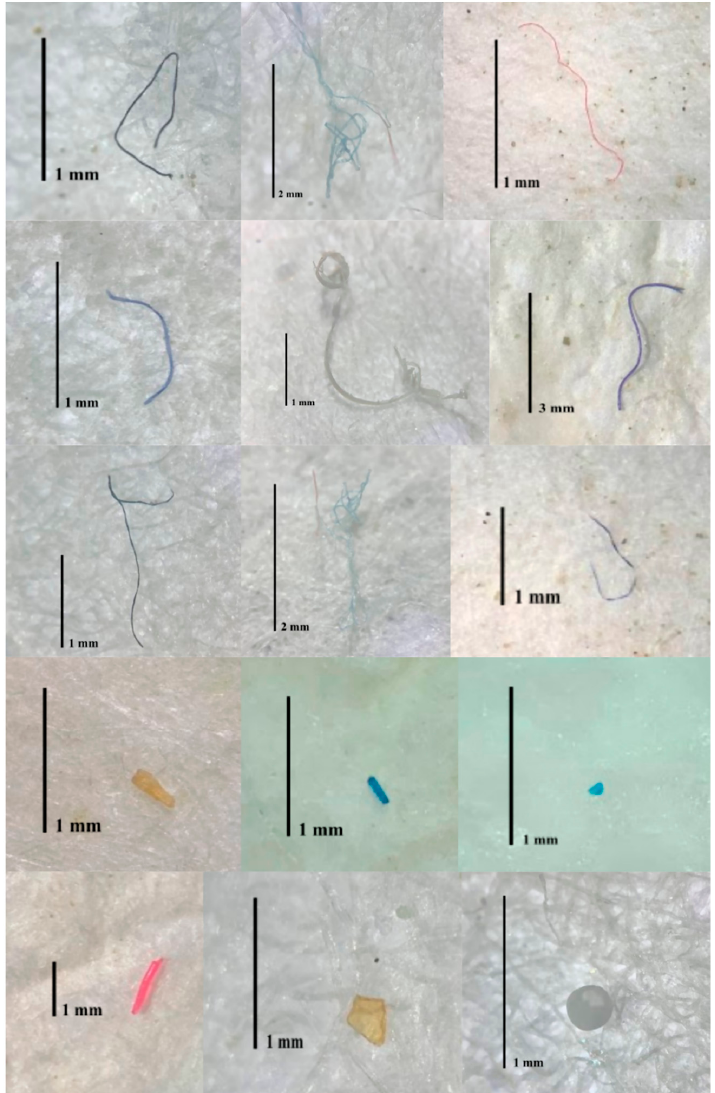
Figure 6. Examples of Microplastics found on the surface water of Luruaco Lake, Low Basin Mag- dalena River, Colombia. dalena River,